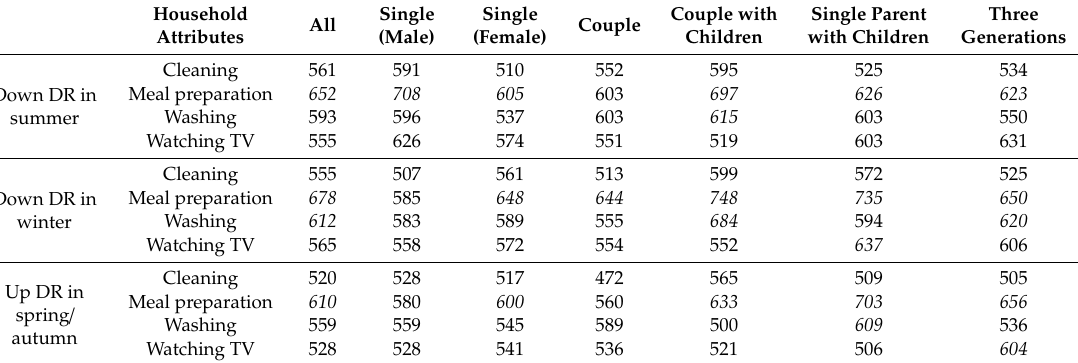
Table 2. Desired monthly reward for responding to a request for each of three types of DR (average, unit: